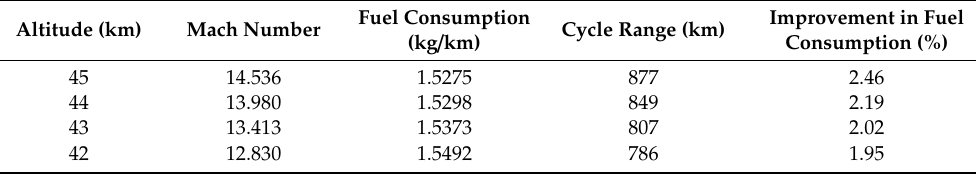
Table 4. Periodic cruise optimization